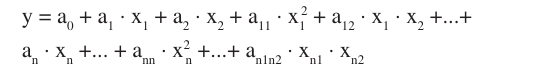
Figure 2. Electronic microscopy scanner pictures of rubber grains (magnifica- tion 100 x ). a) #50; b) #30; and c) >